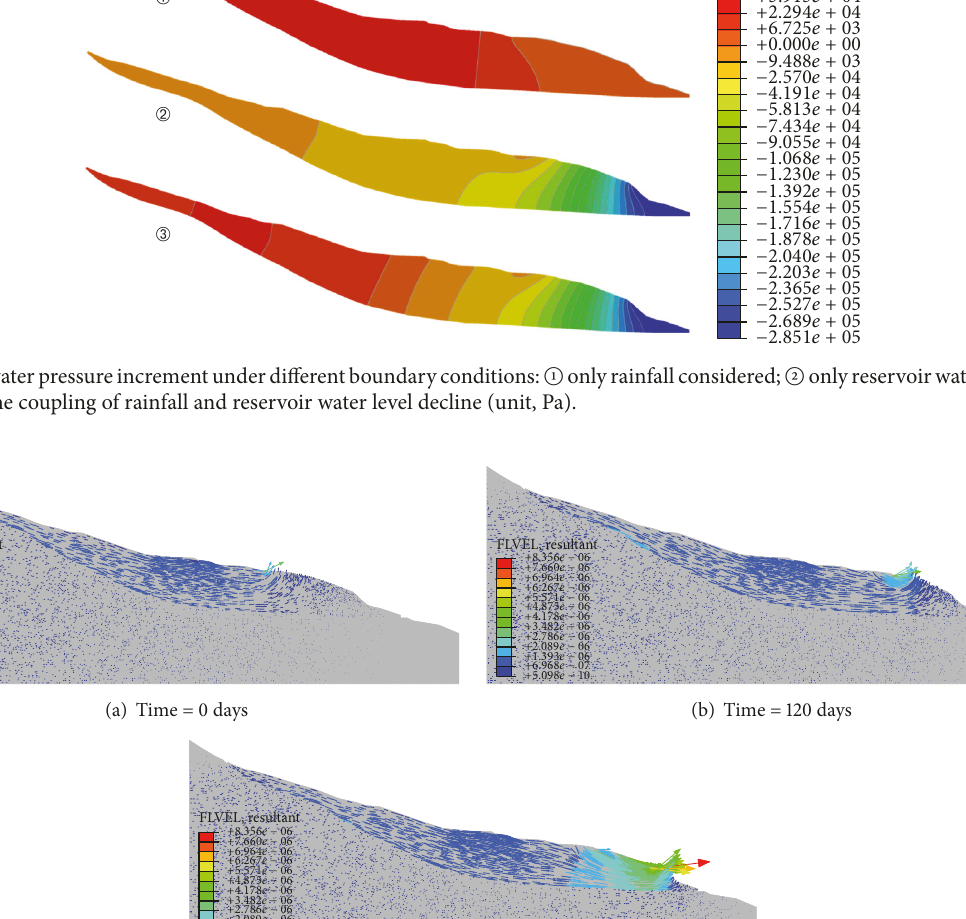
direction, the deformation amplitude increases